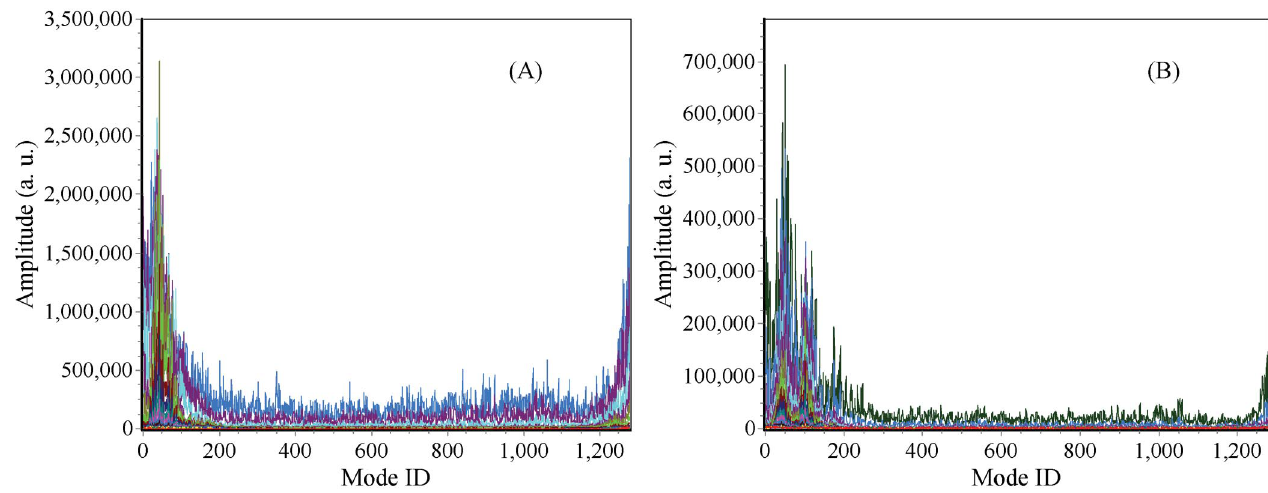
(cid:1) 100% , L (cid:1) sol sol